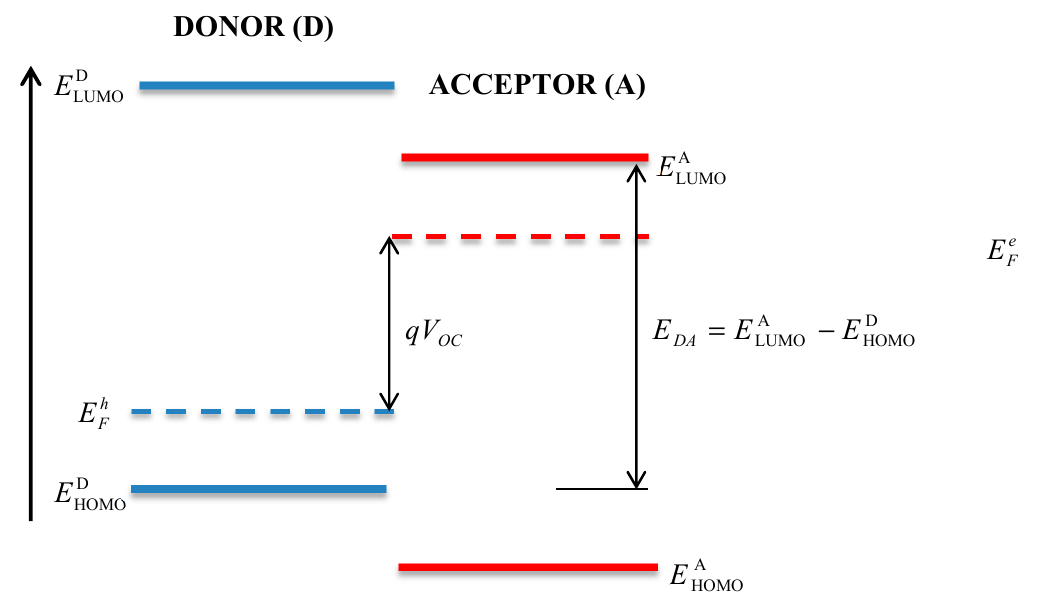
Figure 2. Schematic representation of the different energy levels, quasi-Fermi energy levels, and V OC in a BHJ OSC with a donor-acceptor blend under the open circuit condition.